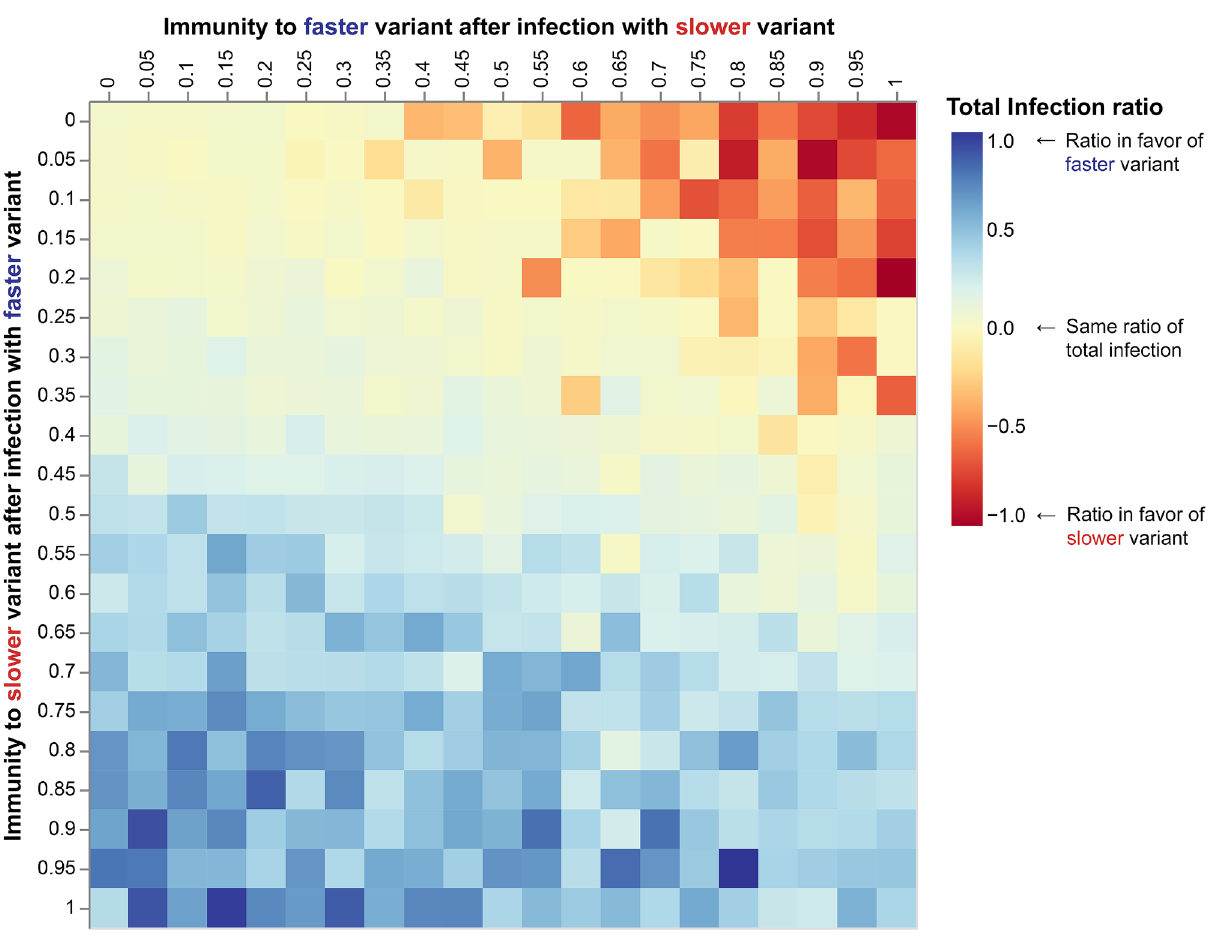
Figure 2. A heatmap of the total infection ratio between the fast and the slow variants under changing conditions of cross-immunity. Immunity between the variants changes from no immunity to full immunity, that is { χ fast → slow , χ slow → fast } ∈ [ 0, 0.05, . . . 1 ] . In the heatmap, low values (denoted in red) correspond to the slow variant infecting the majority of the population, high values (blue) to the faster variant infecting the majority.